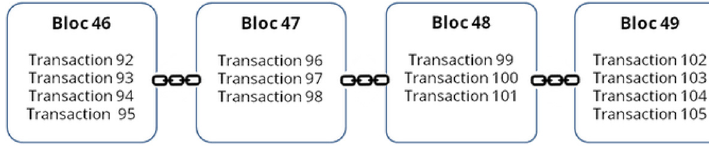
Figure 4. Representation of the blockchain